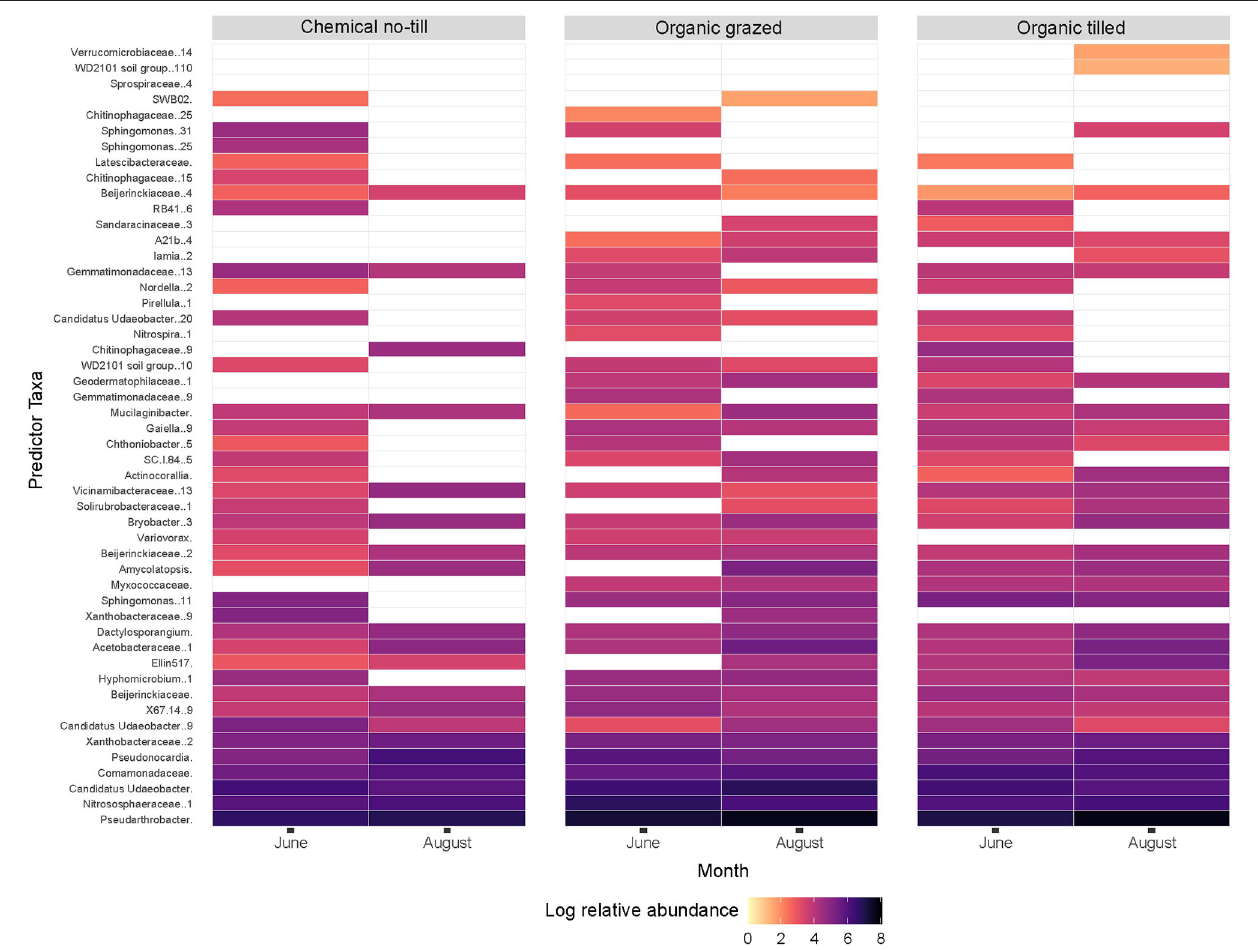
FIGURE 3 | Log relative abundance of the top 50 predictor sequence variants in all cropping systems by month represented by a random forest analysis. White spaces indicate taxa that are absent or at very low abundance. Sequence variants from unspecified genera are identified at the family level.